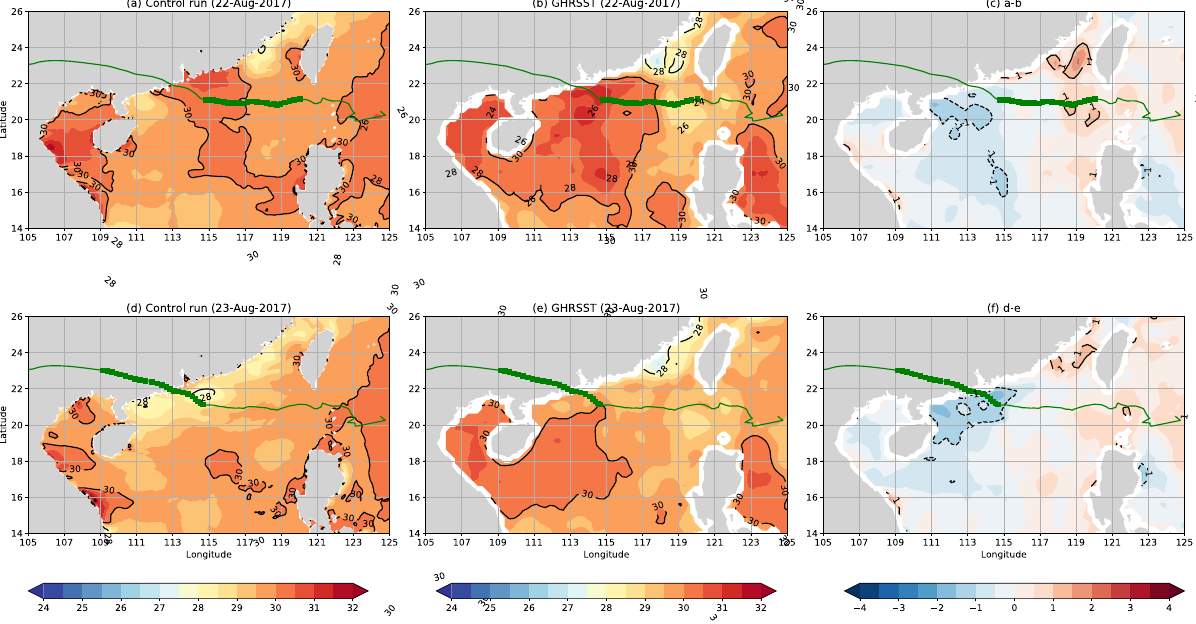
assumptions for the ocean 24 . The model has a single domain of 6km horizontal resolution, covering the north South China Sea (blue box in Fig. 9). There are 21 sigma levels with higher resolution above 200 m depth. The SWAN model solves the wave action balance equation, including physical processes of wind-growth, whitecapping, wave breaking, bottom friction and nonlinear wave-wave interactions 25 . The model run in non-stationary mode with a time step of 2min and has a spectral grid of 36 directions (10° resolution) and 25 frequencies. Its domain is the same as ROMS.